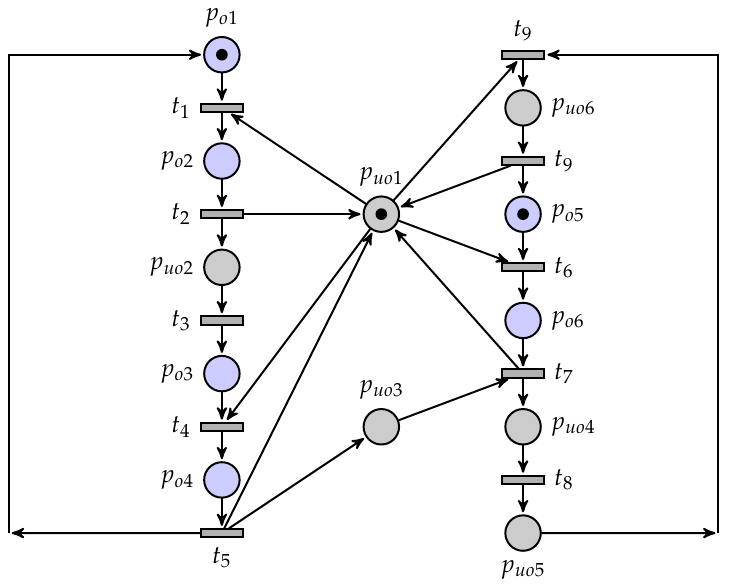
Figure 9. The Petri net